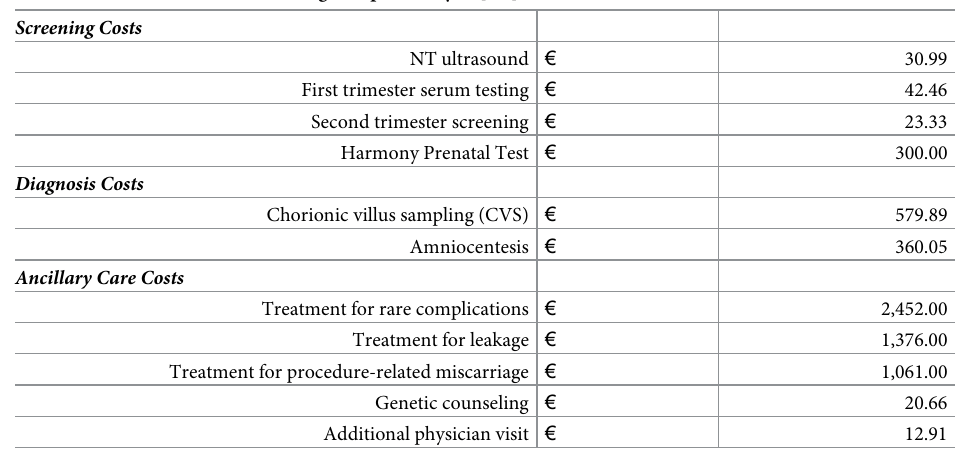
Table 2. Costs considered in the budget impact analysis